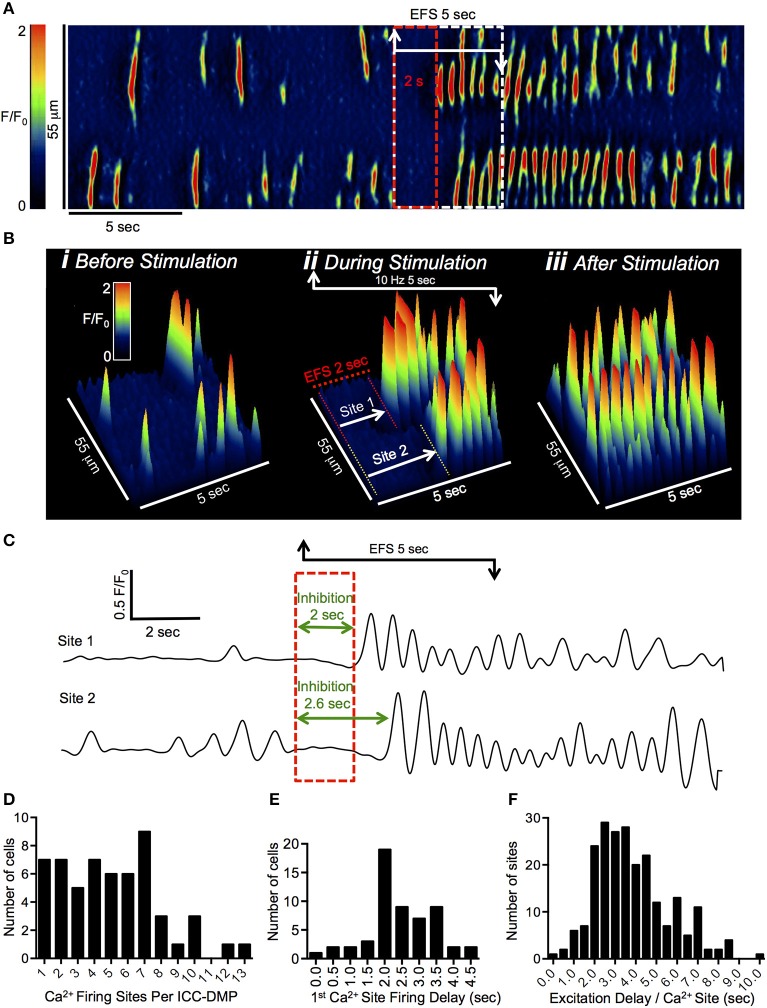
Escape from EFS inhibition occurs at variable times at diferent Ca2+ firing sites in ICC-DMP. (A) Representative ST map of Ca2+ transients in a single ICC-DMP in situ. The period of EFS (10 Hz; 5 s) is indicated by the white dashed box, and the red dashed box highlights the initial 2 s of EFS. (B) 3-D plots illustrating Ca2+ transient firing in the ICC-DMP shown in (A) in the 5 s pre-EFS (i), during EFS (ii), and post-EFS (iii). The white arrows in (Bii) highlight 2 distinct firing sites, which were inhibited during the initial phase of EFS and then escaped inhibition at different times. The durations of inhibition at site 1 and 2 are highlighted by the red and yellow dashed lines, respectively, and the activities of the 2 sites are plotted in (C). The initial 2 s of EFS is indicated by the red dashed box and green lines indicate different inhibition times for each site. (D) Summary histogram showing the number of Ca2+ firing sites contained in ICC-DMP (n = 19, c = 48). (E) Summary histogram showing the timing of the first Ca2+ firing site in ICC-DMP to escape from inhibition during EFS (n = 19, c = 48). (F) Summary histogram showing the times at which all Ca2+ firing sites in ICC-DMP escaped from inhibition during EFS (n = 19, c = 48).